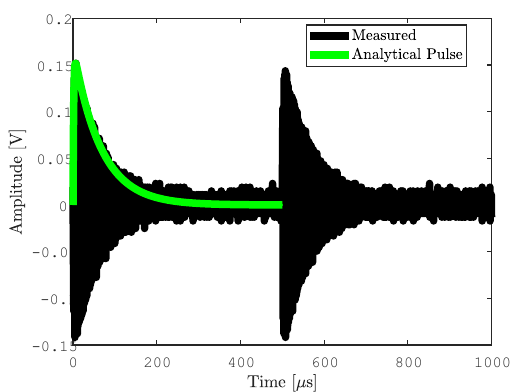
FIGURE 6. Comparison of the amplifier output and the analytical waveforms.